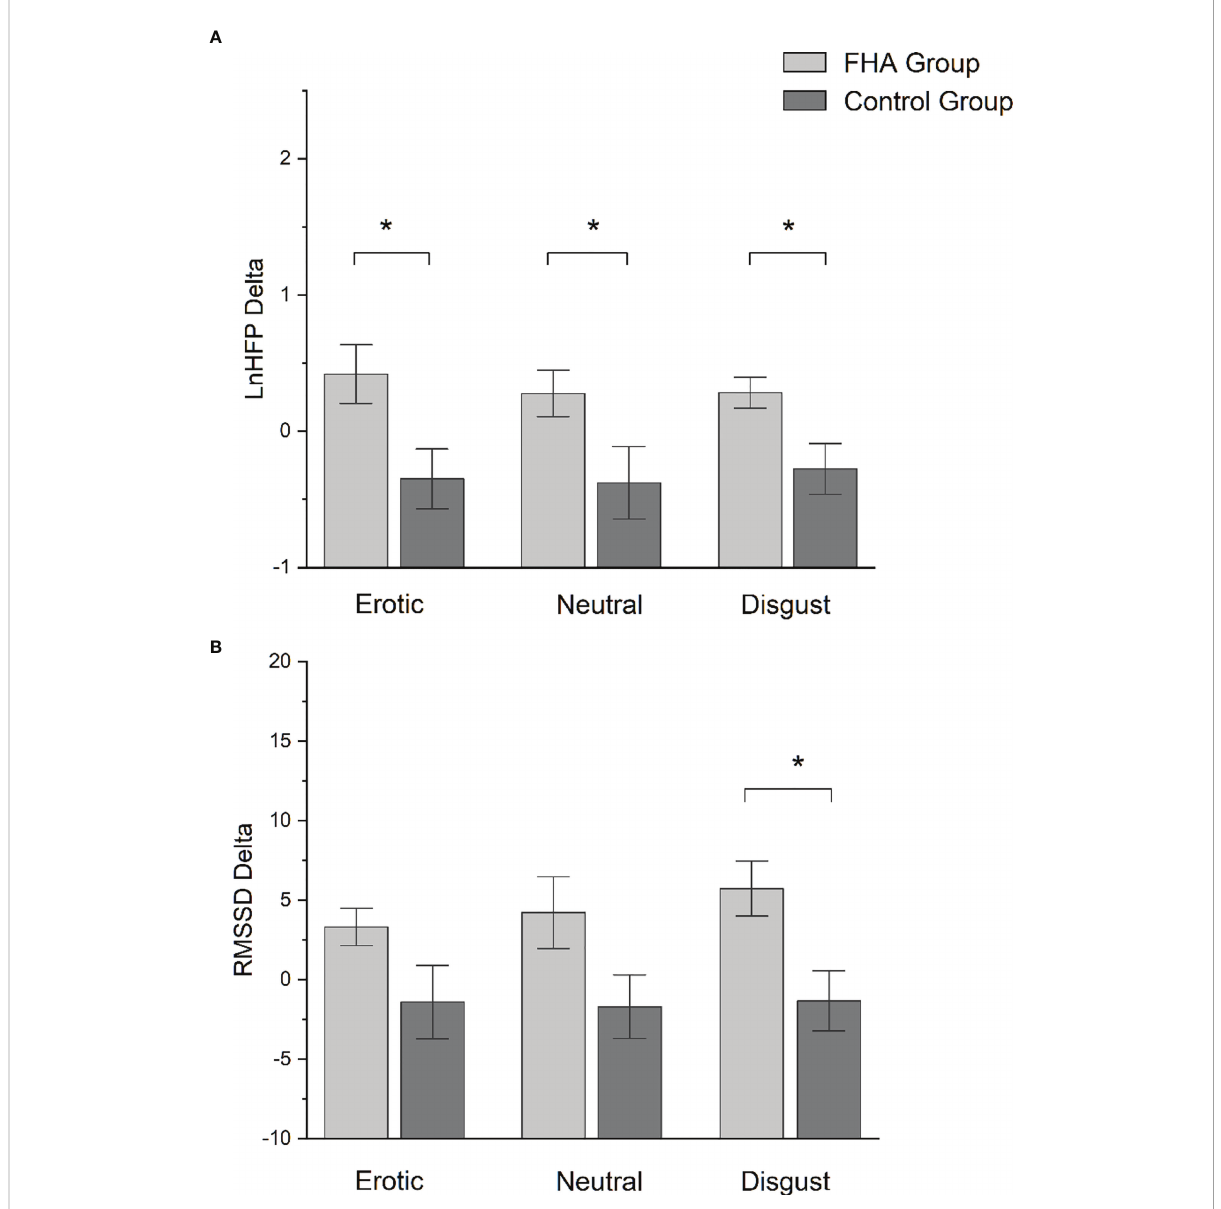
FIGURE 3 (A) Bar-chart representing lnHFP delta in FHA group and control group. Error bars represent standard errors. *p value < 0.05; (B) Bar-chart representing RMSSD delta in FHA group and control group. Error bars represent standard errors. *p value <